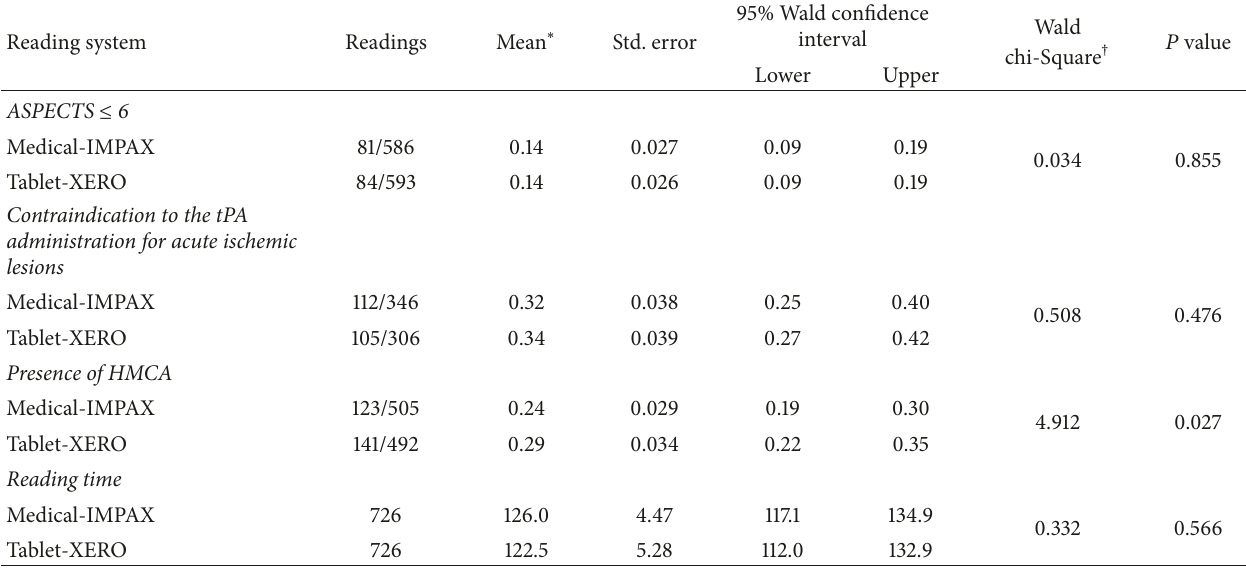
Table 3: Comparison of diagnostic variables and reading time between the reading systems.